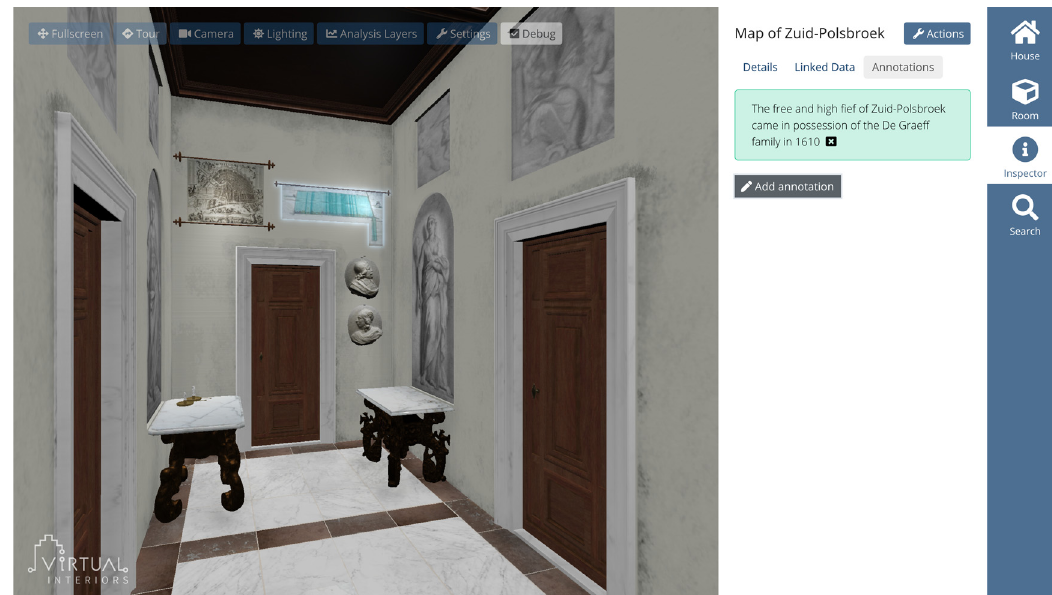
Figure 10: Sample annotation for the map of Zuid -